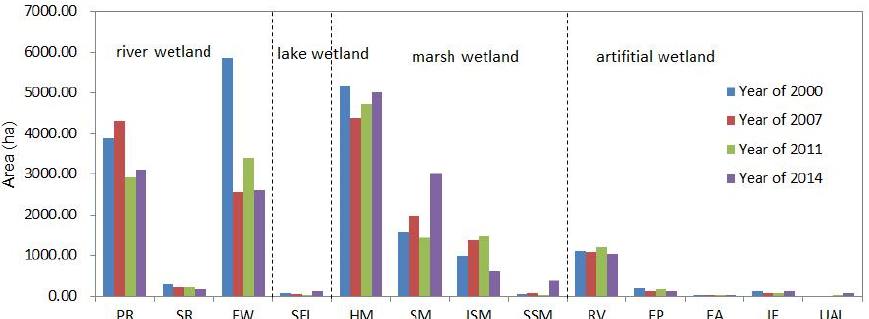
Figure 3. Dynamics of the wetland landscape area in the HRB. The abbreviation of the wetland types: permanent river (PR); seasonal river (SR); flooding wetland (FW); seasonal freshwater lake (SFL); herbaceous marsh (HM); shrub marsh (SM); inland salt marsh (ISM); seasonal salt water marsh (SSM); reservoir (RV); farm pond (FP); freshwater aquaculture (FA); irrigation field (IF); urban artificial landscape and recreational wetland (UAL) .